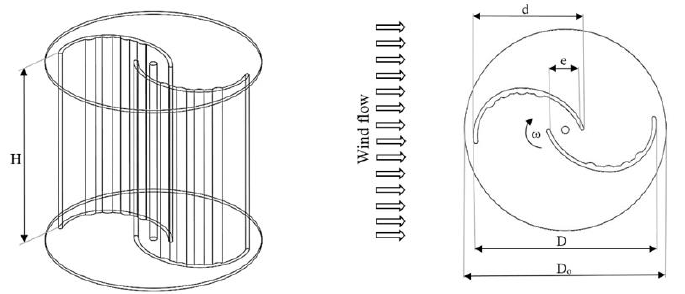
Figure 3. S-ORM geometry employed in the computational and experimental models with H/D = 1, e = D/5 = d/3 ≈ 0.2, and BLN = 2.